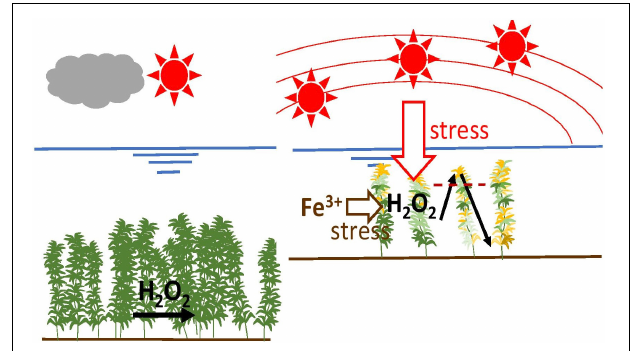
FIGURE 1 | Overall overview of stress mechanism based on light intensity and Fe.